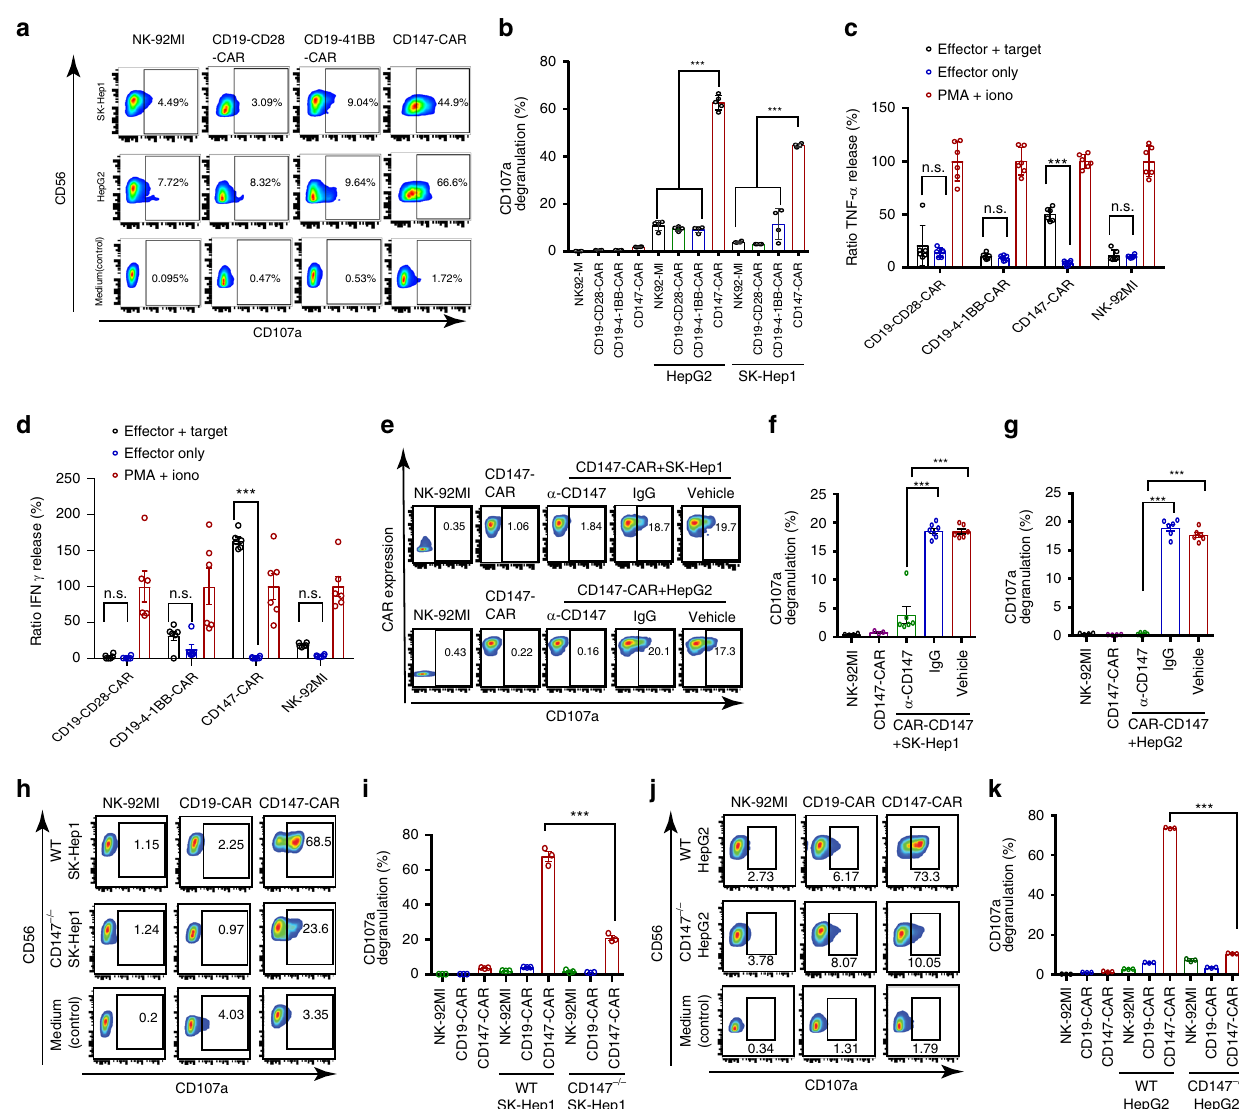
Fig. 1 Activation pro fi les of CD147-CAR-NK-92MI stimulated with sensitive target cells. a Representative fl ow cytometric data illustrating CD107a degranulation by NK-92MI, CD19-4-1BB-CAR, CD19-CD28-CAR, and CD147-CAR after mixing with the medium (control), SK-Hep1, and HepG2. b Quantitative data for the percentage of surface CD107a expression on CD147-CAR-NK-92MI cells upon different stimulations, as indicated. Data represent the mean ± SEM ( n = 4). c , d Cytokine TNF- α ( c ) and IFN γ ( d ) production by CD147-CAR-NK-92MI, CD19-4-1BB-CAR-NK-92MI, CD19-CD28- CAR-NK-92MI, and wild-type NK-92MI stimulated by different conditions. Data are pooled from four independent experiments. e Representative data showing the percentage of surface CD107a expression on CD147-CAR-NK-92MI cells upon different stimulations, as indicated. Isotype-mouse IgG (IgG) or PBS (vehicle control group) was used, as indicated. f , g Quantitative data for the percentage of surface CD107a staining on CD147-CAR-NK-92MI cells stimulated with CD147 + SK-Hep1 and CD147 + HepG2 cell lines. Wild-type NK-92MI cells alone and CD147-CAR-NK-92MI cells alone were used as controls, as indicated. Data represent the mean ± SEM of four independent experiments. h Representative data showing the percentage of surface CD107a expression on CD147-CAR-NK-92MI cells stimulated with CD147 + wild-type (WT) SK-Hep1 cell line (top panel) and CD147-knockout (CD147 − / − ) SK- Hep1 cell line (middle panel). i Quantitative data for the percentage of surface CD107a staining on CD147-CAR-NK-92MI cells stimulated with CD147 + SK- Hep1 (WT) and CD147-knockout SK-Hep1 (CD147 − / − ) cell lines, respectively. Data represent the mean ± SEM of three independent experiments. j Representative data showing the percentage of surface CD107a expression on CD147-CAR-NK-92MI cells stimulated with a CD147 + wild-type (WT) HepG2 cell line (top panel) and a CD147-knockout HepG2 cell line (middle panel). k Quantitative data for the percentage of surface CD107a staining on CD147-CAR-NK-92MI cells stimulated with CD147 + HepG2 (WT) and CD147-knockout HepG2 (CD147 − / − ) cell lines, respectively. Data represent the mean ± SEM of three separate experiments. Unpaired Student ’ s t test was employed for all the panels. *** p < 0.001; n.s. not signi fi